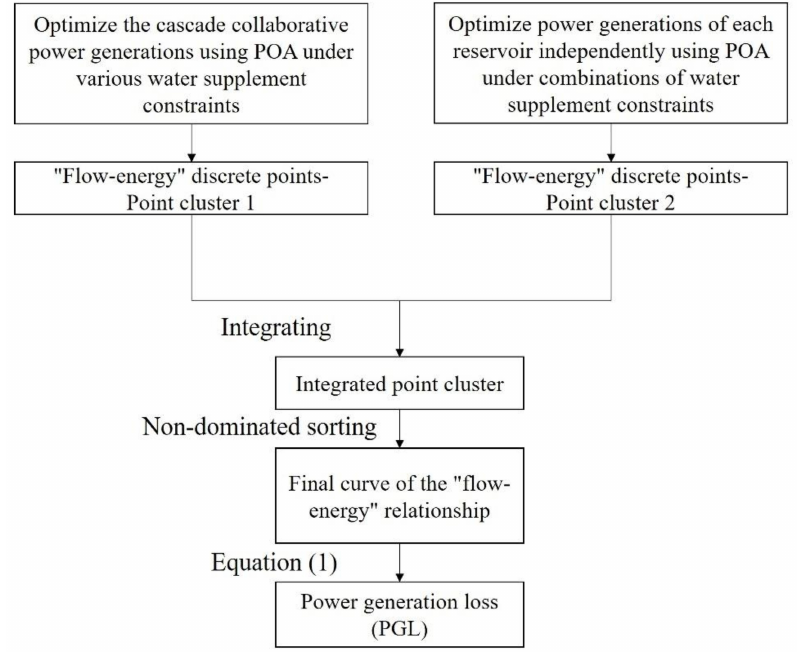
Figure 4. The calculation of process of “flow-energy” relationship and PGL using the “collaborative- independent” joint optimization